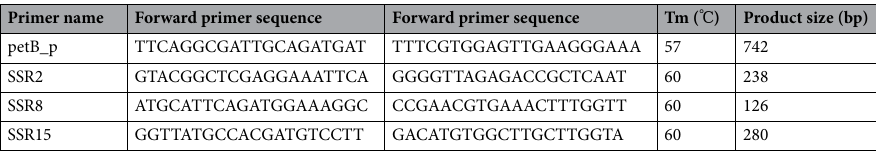
Table 6. Designed primer for SNP validation and molecular